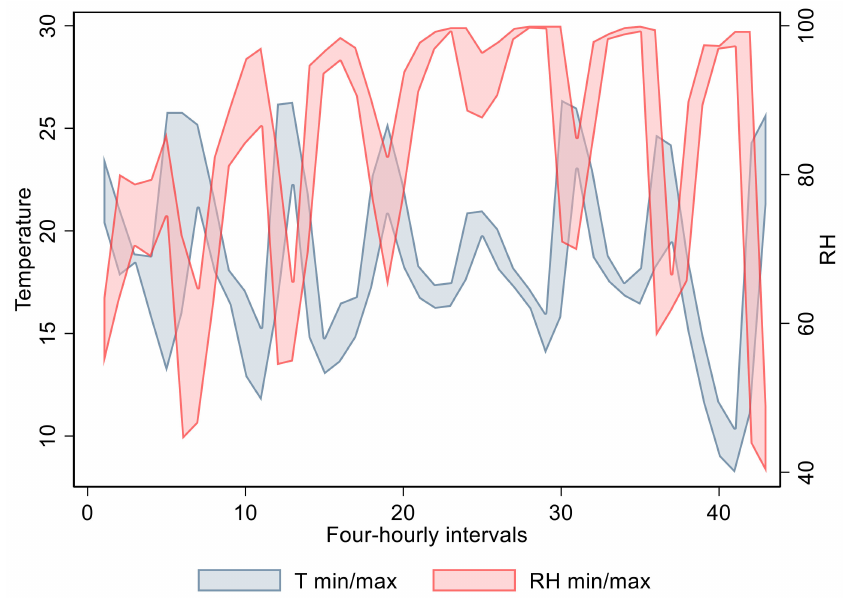
Figure 1. Range of T (temperature in ◦ C) and RH (relative humidity in %) during the seven-day period of treatment